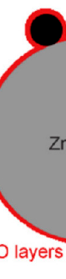
16 of 42 Figure 22. Effect of Ti 3 AlC 2 loading on the performance of TiO 2 for photocatalytic dry reforming of methane. Copyright (2020), reprinted from [36] with permission from Elsevier. Employing CeO 2 in photocatalytic methane reforming is promising because CeO 2 is known to have many oxygen vacancies, which provides various merits in catalytic activity